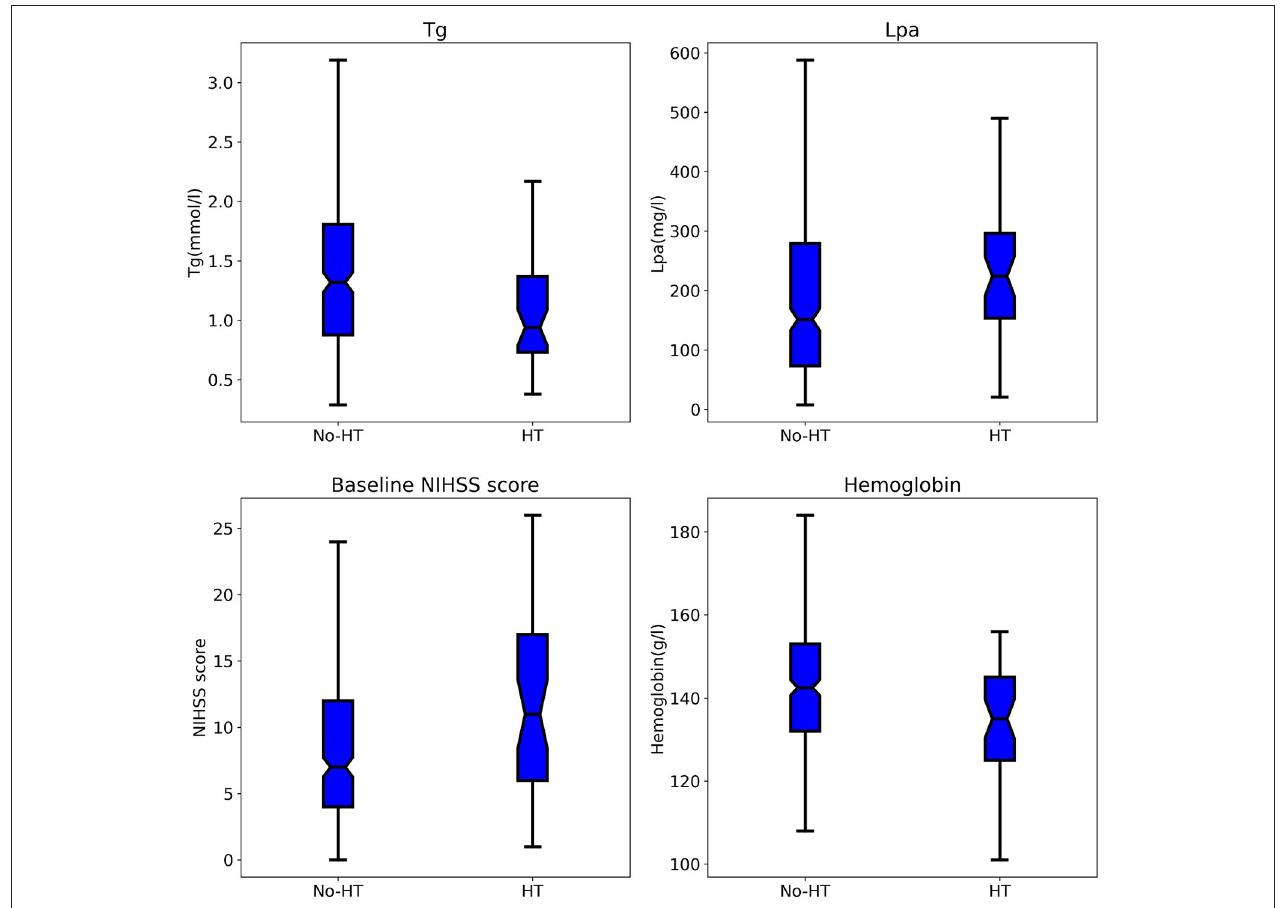
FIGURE 2 | Comparison of Tg, Lpa, baseline NIHSS score, hemoglobin between patients in the HT and no-HT group. Tg, triglycerides; Lpa, lipoprotein(a); HT, hemorrhage transformation.